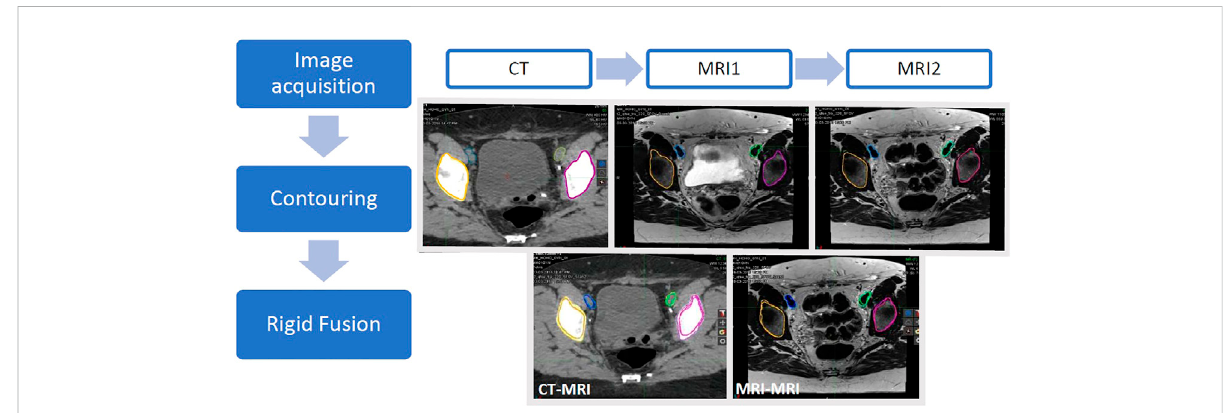
FIGURE 1 Schematicrepresentationofthework fl ow.CT,MRI1andMRI2imageswereacquiredonthesamedaywiththepatientsetupintheradiotherapy treatment position for each scan. Anatomical structures (left and right acetabulum and left and right external iliac vessels) were contoured on the three image datasets. Rigid registrations between the CT and each MRI dataset (CT-MRI) as well as the two MRI datasets (MRI-MRI) were performed.